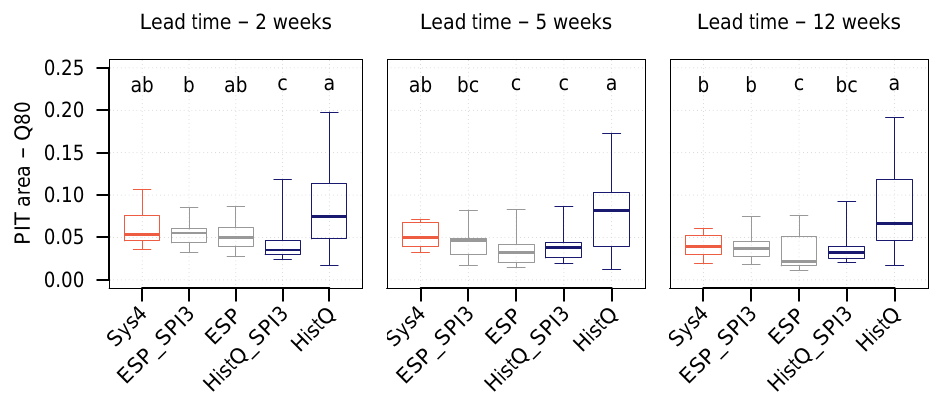
Figure 9. Same as Fig. 7 but for PIT area ranges computed for deficit duration. Ranges are represented by box plots that gather the PIT areas for the 16 catchments. Graphs are presented for lead times of 2 weeks, 5 weeks and 12 weeks (columns).